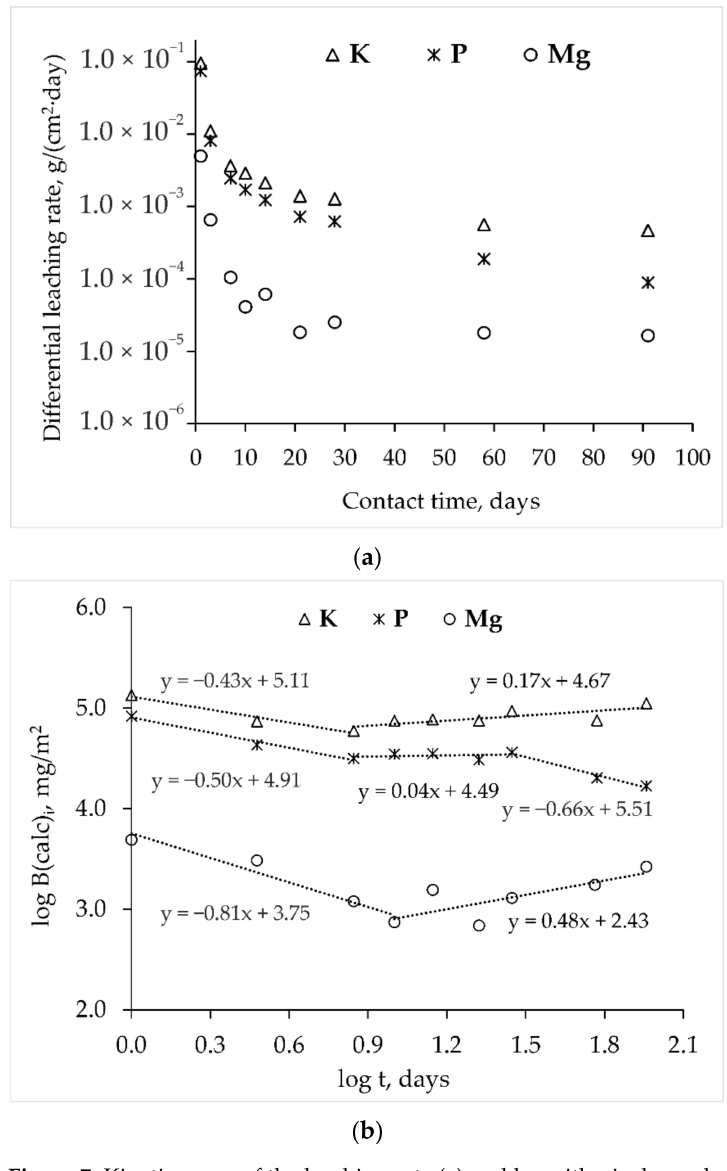
Figure 7. Kinetic curve of the leaching rate ( a ) and logarithmic dependence of the release ( b ) of the matrix components from the MPP